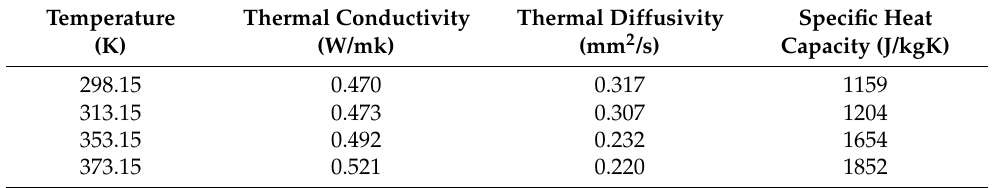
Table 5. Thermophysical properties of PLA/6 wt% GNPs 1